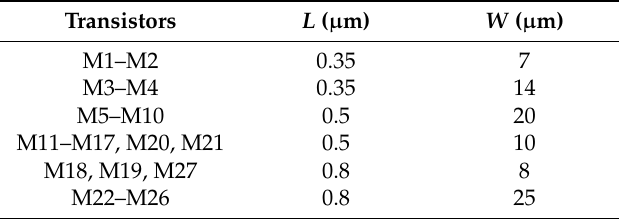
Figure 11. Simulated result of operation as an ASK signal generator when I B 2 is the applied pulse signal. Table 3. The aspect ratios of the CMOS transistors in MO-CCCCTA